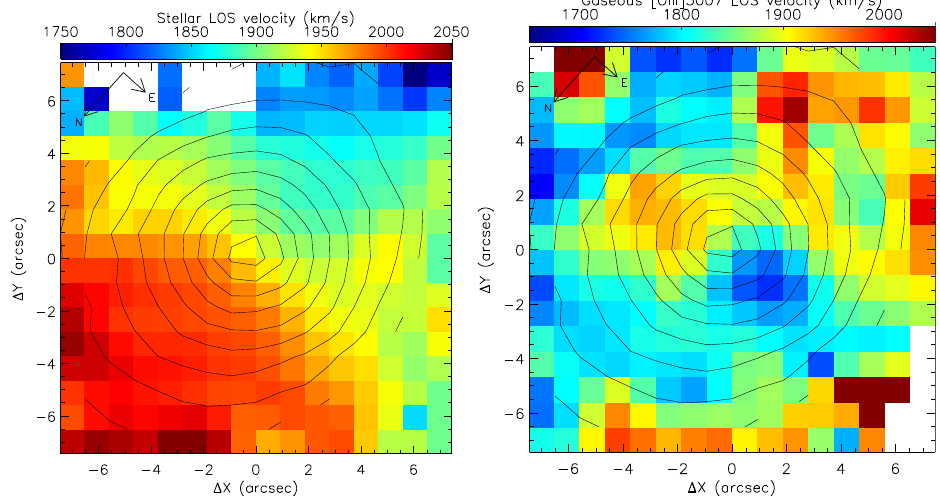
Figure 1. The stellar and ionized-gas line-of-sight velocity fields for the central part of the gas-rich S0 galaxy NGC 2962 obtained with the IFU Multi-Pupil Fiber Spectrograph (MPFS) of the Russian 6m telescope (A. V. Moiseev, private communication); the broad-band green isophotes are superimposed. Despite the visible orthogonality of the rotation planes, the true mutual inclination between the stars and the gas rotation axes can be either 84 ◦ or 60 ◦